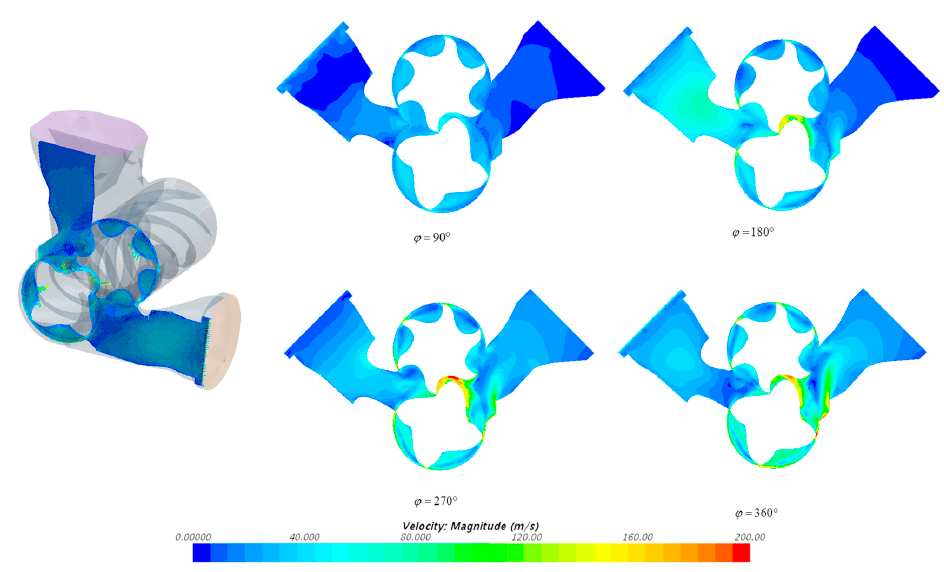
Figure 11. Cross-section of the velocity distribution in the vicinity of the discharge port.